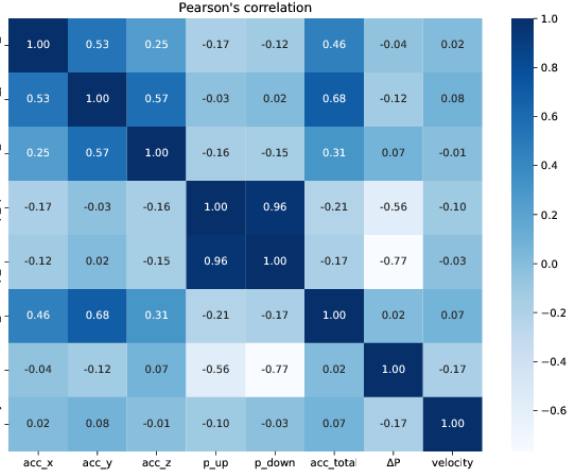
Figure 43. Heat map representation of Pearson’s correlations for the training set.